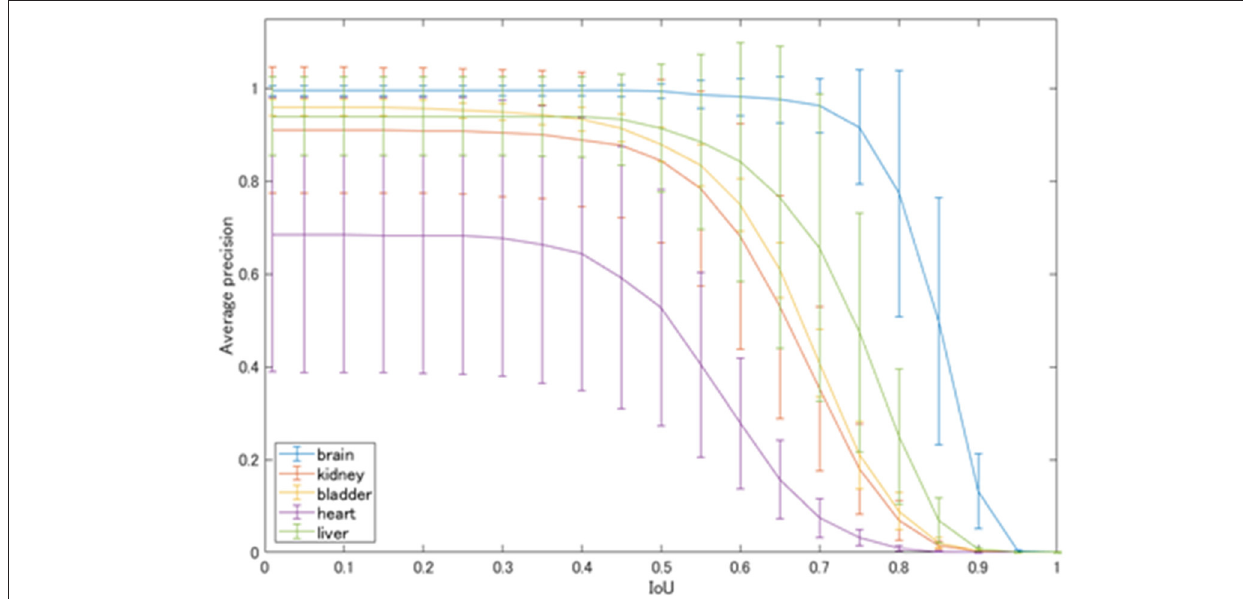
FIGURE 4 | Average precision of each physiological uptake.